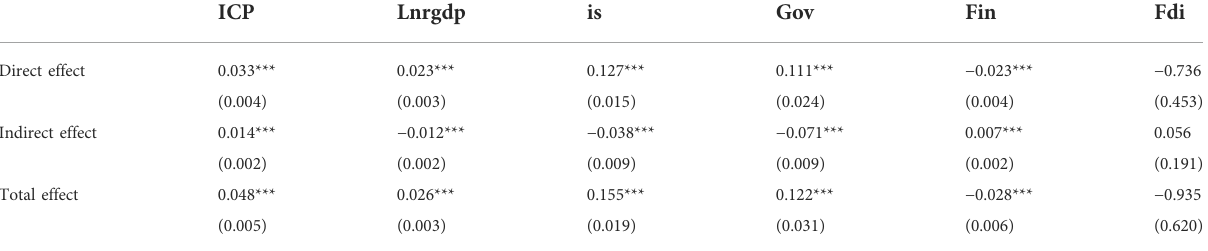
TABLE 5 Direct effect, indirect effect, and total effect of SDM in Table